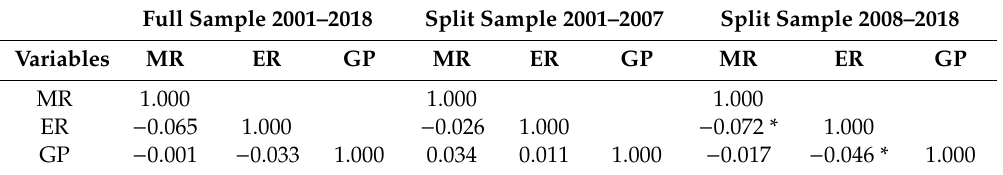
Table 2. Correlation matrix—full sample.